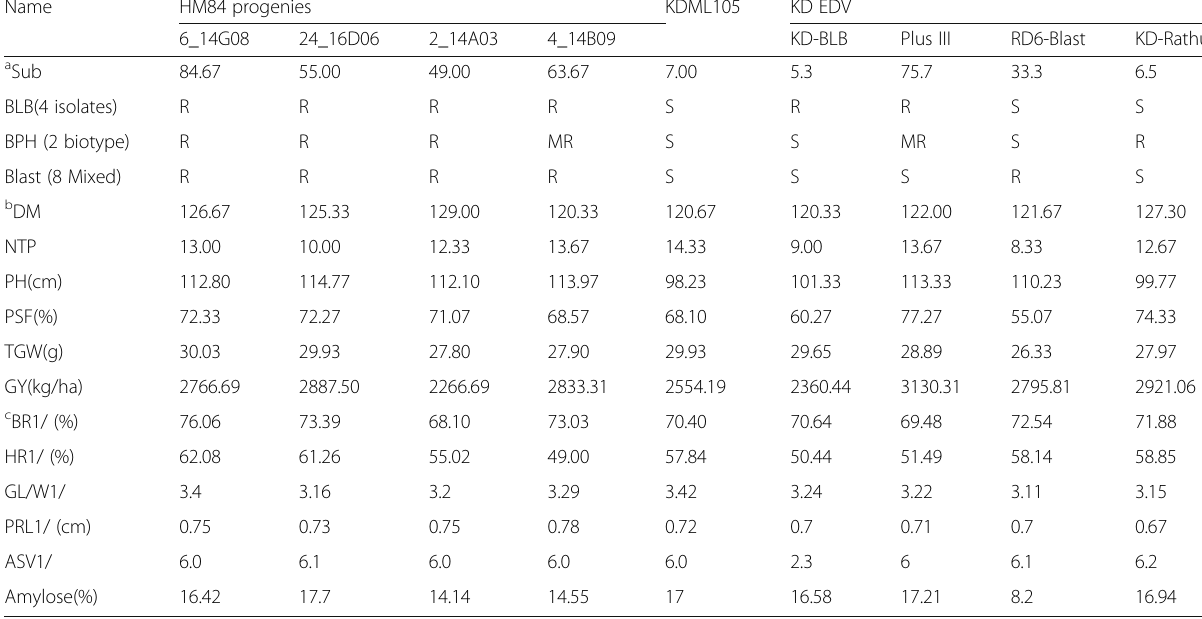
Table 4 Trait evaluation, agronomic characteristics, grain quality, and cooking quality traits of the four selected HomMali 84, KDML105, and KD EDVs (For trait evaluation methods, see Additional file